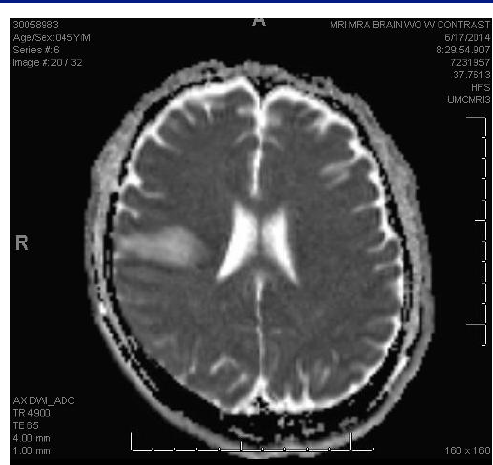
Figure 2 : Confluent area of increased FLAIR/T2 signal intensity with intense enhancement and central necrotic change within the right frontoparietal lobe showing